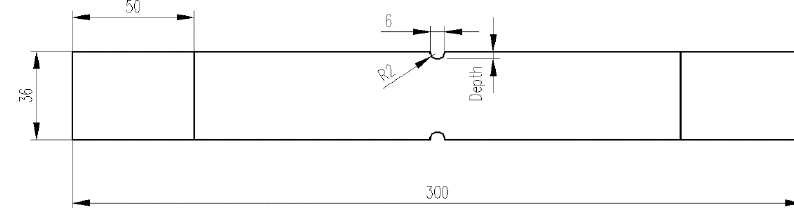
Figure 1: Drawing of double edge notch specimens (Depth: 2mm, 3mm and 4mm)